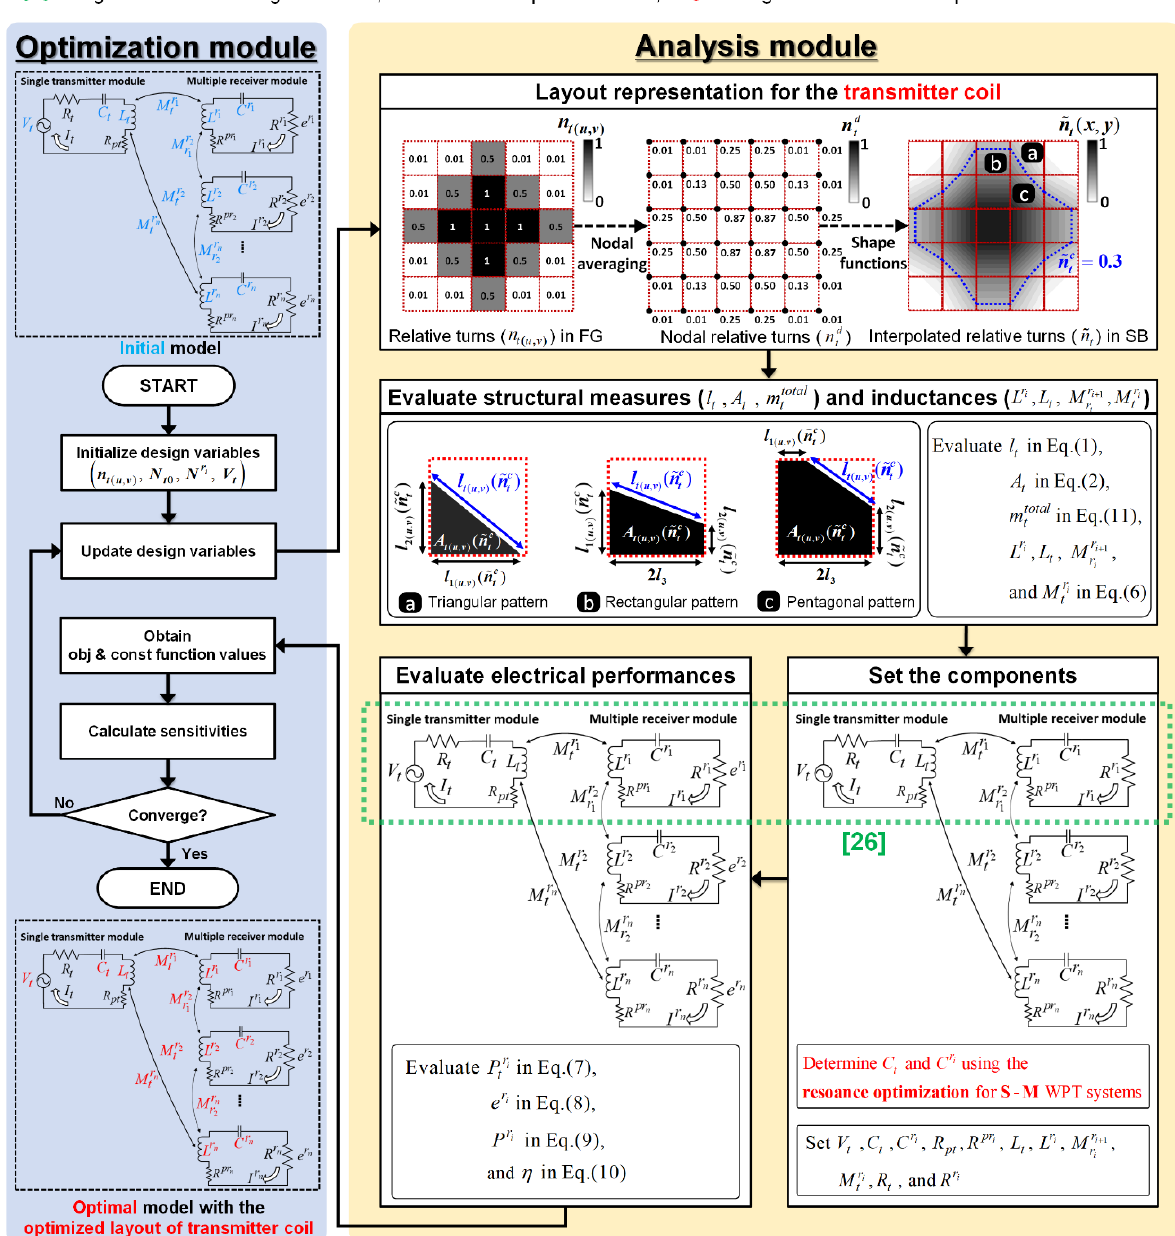
Figure 1. Concept of the proposed transmitter module optimization for single transmitter to multiple receivers (S-M) wireless power transfer (WPT) systems. Note: Eq.: Equation.